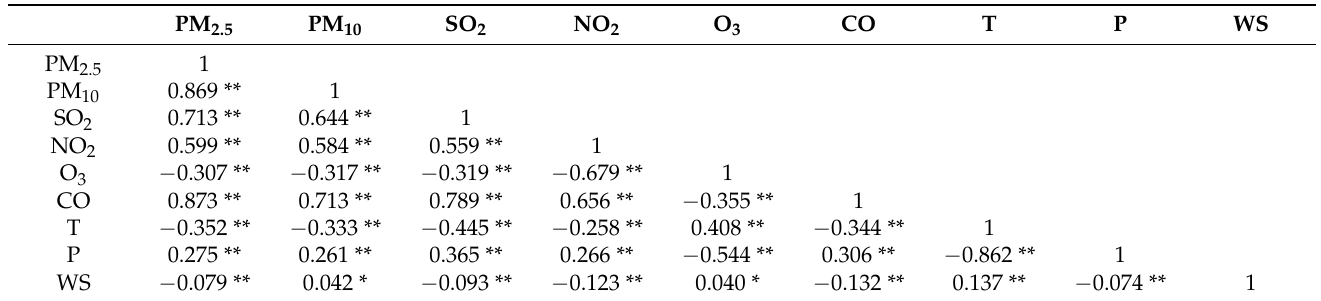
Table 2. Results of Pearson correlation